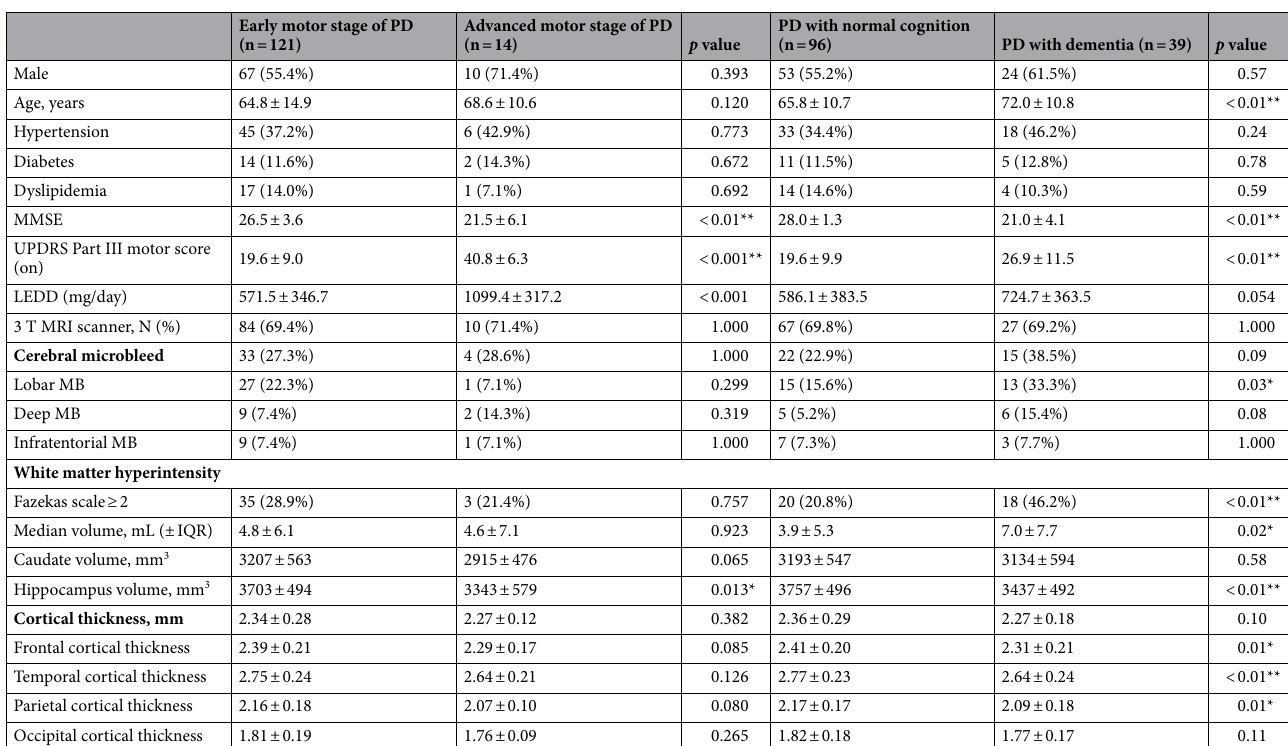
Table 2. Demographics and image characteristics in Parkinson’s disease patients. Values are given as mean ± standard deviation or n (%) unless otherwise noted. Hoehn-Yahr stage < 3 was defined as early motor stage of PD, and stage ≥ 3 was defined as advanced motor stage of PD. N number, IQR interquartile range, MB microbleed, PD Parkinson’s disease, MMSE mental state examination, UPDRS Unified Parkinson’s Disease